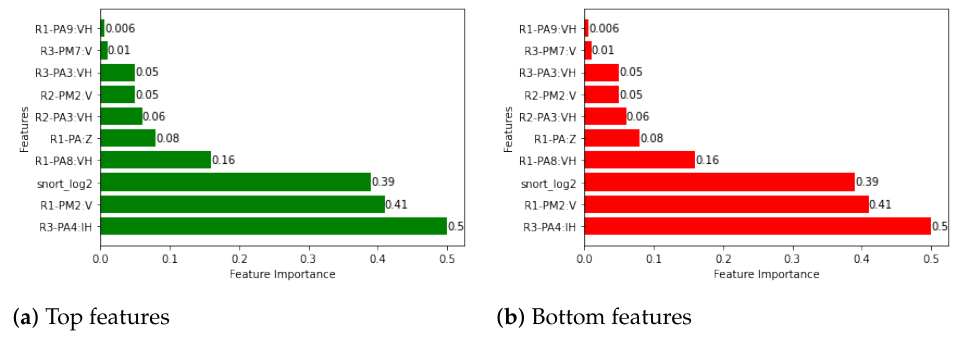
Figure 4. Ten top and bottom features with individual score using filter method. Table 4. Water Treatment Plant: Ten top and bottom features with their importance values using the filter and wrapper